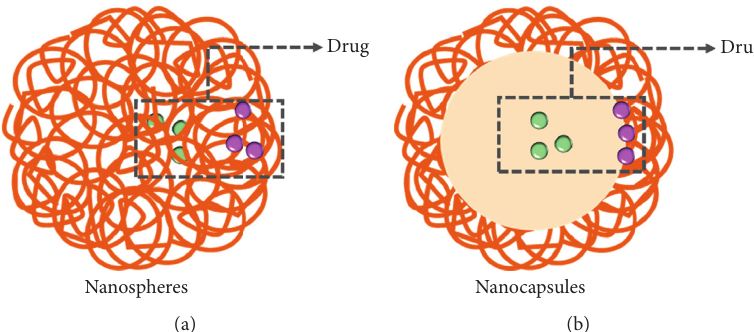
Figure 7: The types of polymeric NPs. (a) The drug could be dispersed or covalently bound to the polymer matrix in nanospheres. (b) The drug could be encapsulated in the interior of the vesicular cavity or enclosed by the solidified polymeric shell in